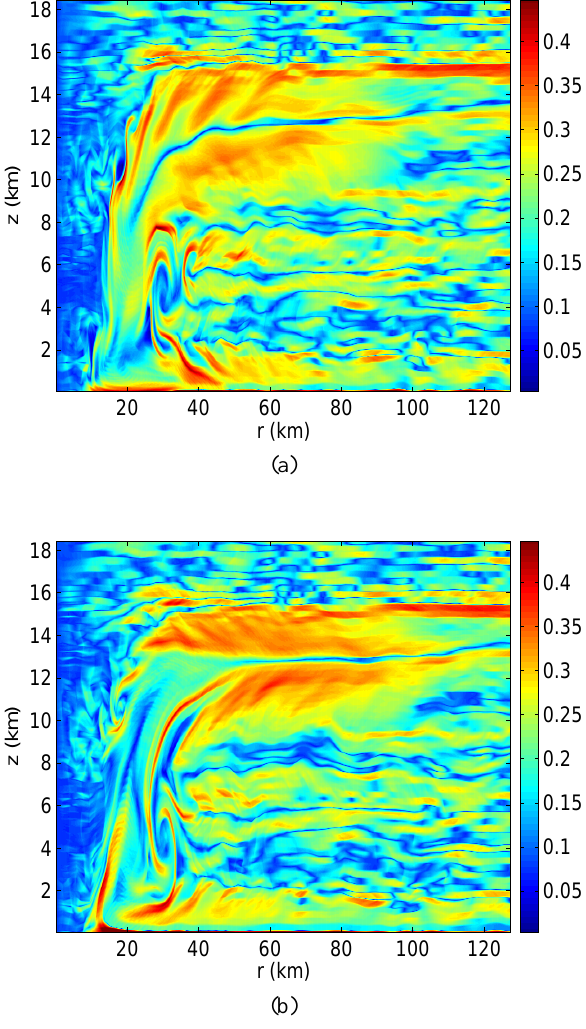
Fig. 4. FTLE distrbution function G ( t,t 0 ) (a), log( G ( t,t 0 ) − A 1 ′ ) (b) , and relative error (c) plotted versus integration time T for the 6 mixing boxes with trajectories seeded at t 0 = 400 min. Other initial times give similar decay structure but different quantitative details.